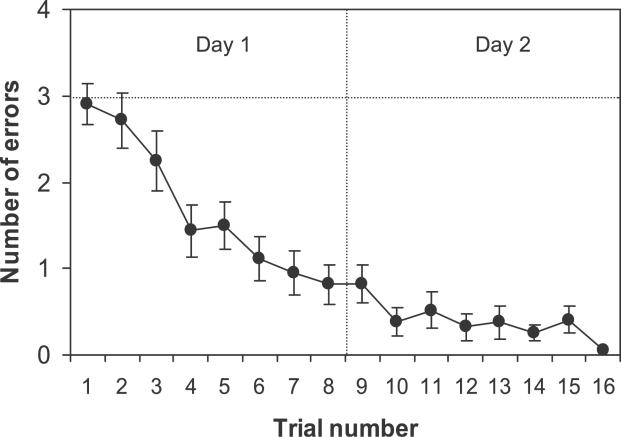
The Mean (± SE) Number of Errors per Trial Made on the Associative Learning Task by Experimental Birds (see
Materials and Methods)
All birds (i.e., both sexes and birds from both early nutrition treatment groups) are included (
n = 34). The dotted line indicates the number of errors expected by chance. The dashed line denotes a 24-h retention interval (i.e., trial 9 was the first trial of day 2). Sex, early diet, and family of origin did not influence the pattern of decline in errors with trial number (mixed model using a binomial error distribution where trial number was a repeated measure within bird identity [random effect]: trial number:
z = 14.07,
p < 0.0001; bird identity:
z = 0.13,
p = 0.45; family of origin [random factor]:
z = 1.12,
p = 0.13; sex:
F
1,13.4 = 0.05,
p = 0.82; early diet:
F
1,13.7 = 0.74,
p = 0.40), nor did the foster family in which the experimental birds were reared affect learning performance (
F
18, 15 = 0.56,
p = 0.88).